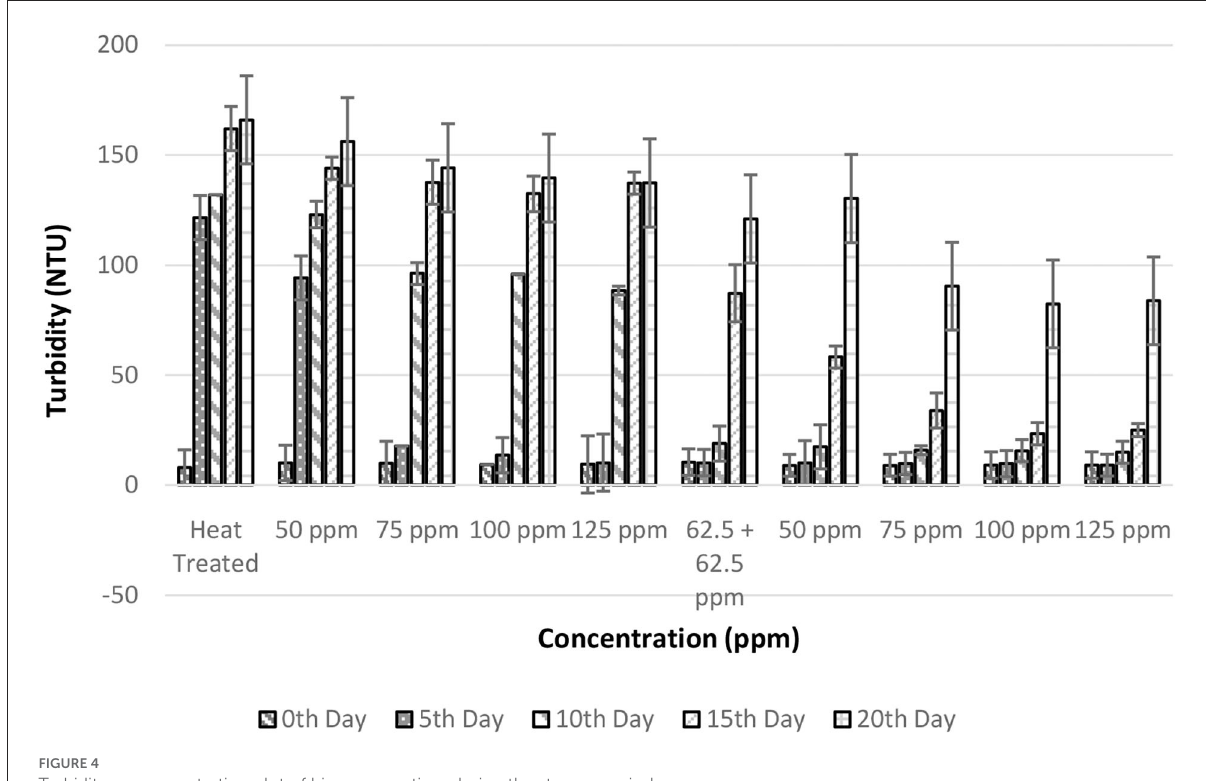
FIGURE4 Turbidity vs. concentration plot of bio-preservatives during the storage period.